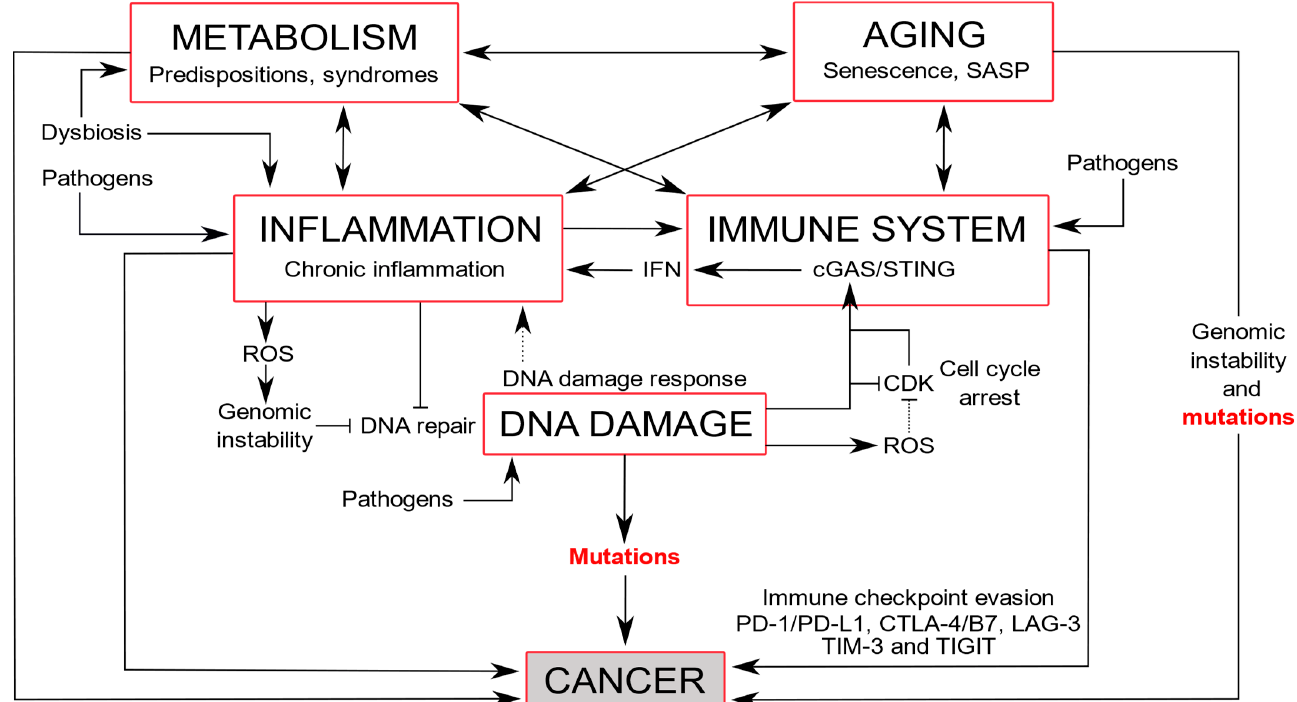
Figure 3. DNA damage induces inflammation and immunity that connect to metabolism and aging, with the genesis of mutations leading to cancer formation. The DNA damage response is activated upon DNA damage, arresting the cell cycle by CDK inhibition, and triggering an inflammatory response. cGAS, a cytosolic DNA sensor, triggers an innate immune response that activates STING. In mitosis, the CDK1-cyclin B complex phosphorylates and inhibits cGAS, but upon mitotic exit, dephosphorylation of cGAS by PP1 enables DNA cytoplasmic sensing [163]. cGAS connects DNA damage to the immune system, and subsequent inflammation by the production of interferon (IFN) and cytokines, but also to senescence and cancer [164]. Chronic inflammation can lead to an impairment of the immune system and generate ROS that counteracts DNA repair mechanisms [165]. Immunity triggers an inflammatory process that increases blood pressure, stimulating organ and metabolism damage [166,167]. Metabolism shifts with increased oxygen consumption and the generation of reactive nitrogen and oxygen intermediates are associated with inflammatory and immune responses [168]. Dysbiosis produces inflammation and metabolism syndromes that contribute to senescence. Pathogens can induce DNA damage and trigger immune and inflammatory responses. Aging is associated with adaptative immune and inflammatory responses and cumulative DNA damage and genomic instability that increase mutations [169,170]. Cancer cells evade detection by the immune system using immune checkpoints PD-1/PD-L1 (programmed cell death protein 1/programmed cell death ligand 1) and CTLA-4 (anti-cytotoxic T lymphocyte-associated antigen-4), LAG-3 (lymphocyte activation gene-3), TIM-3 (T cell immunoglobulin and mucin domain containing-3), and TIGIT (T cell immunoglobulin and ITIM domain)